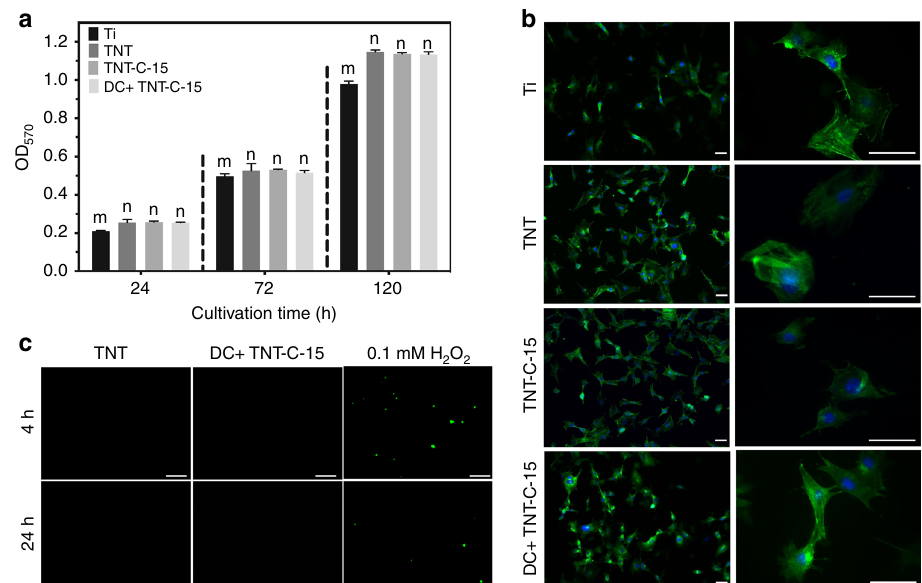
Fig. 7 Biocompatibility assessments. a Quantitative determination of the cell viability on various samples (signi fi cant differences between groups are marked by m and n, P < 0.05, SNK test in ANOVA). b Cell morphology of MC3T3-E1 osteoblasts cultivated on different samples for 24 h (Scale bar = 50 μ m). c ROS observation of MC3T3-E1 osteoblasts cultured on different samples for 4 h and 24 h (Scale bar = 100 μ m). All error bars = s.d. ( n =